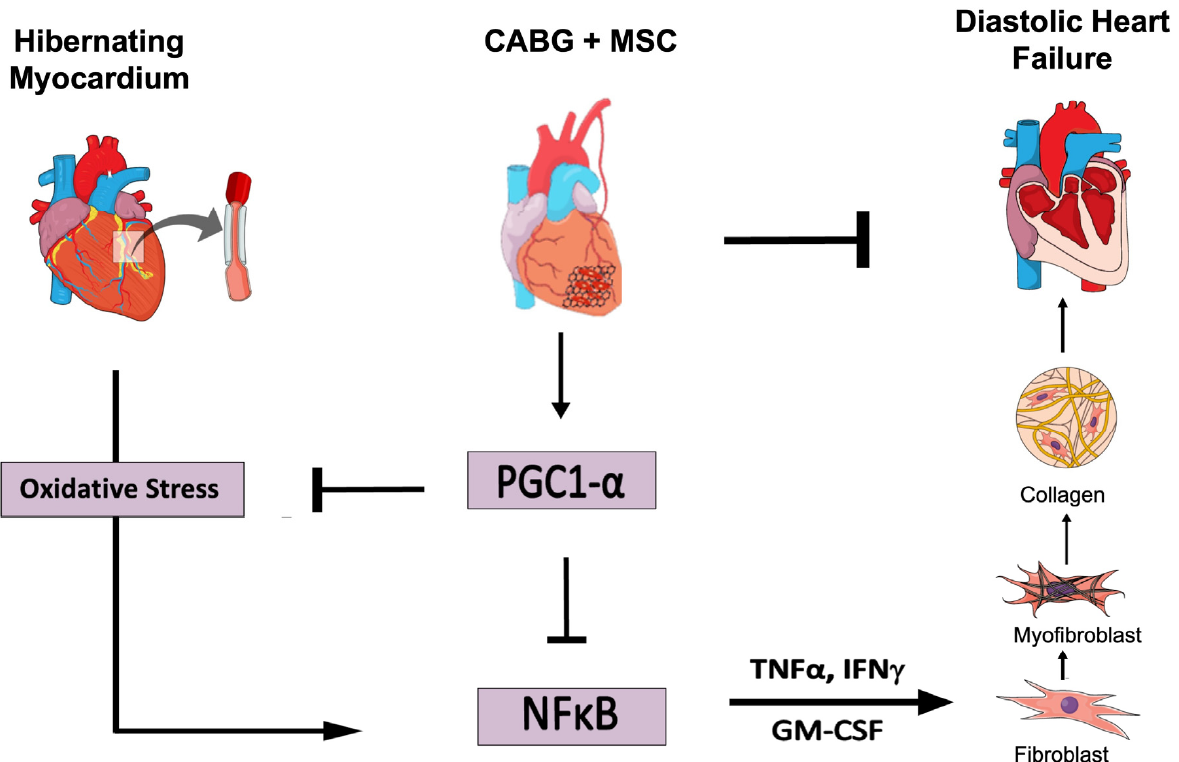
Figure 5. Adjuvant therapy with an epicardial placement of a mesenchymal stem cell (MSC) patch at the time of CABG improves diastolic function by reducing oxidative stress, pro-inflammatory signaling, and myofibroblast presence in myocardial tissue. CABG = Coronary artery bypass graft, GM-CSF = Granulocyte-Macrophage Colony-Stimulating Factor, IFN γ = Interferon gamma, IL-1 β = Interleukin 1 beta, MSC = Mesenchymal Stem Cells, NF κ B = Nuclear Factor Kappa-Light-Chain Enhancer of Activated B Cells, PGC1 α = Peroxisome Proliferator-Activator Receptor Gamma Coactivator 1-Alpha, TNF α = Tumor Necrosis Factor. (Figure created in the Mind the Graph platform: www.mindthegraph.com, accessed on 25 August 2022).